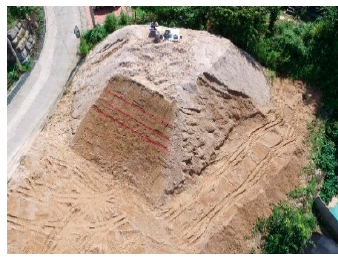
Figure 3. Cross-section diagram of the model slope. Figure 4. Construction of the model slope. Figure 4. Construction of the model